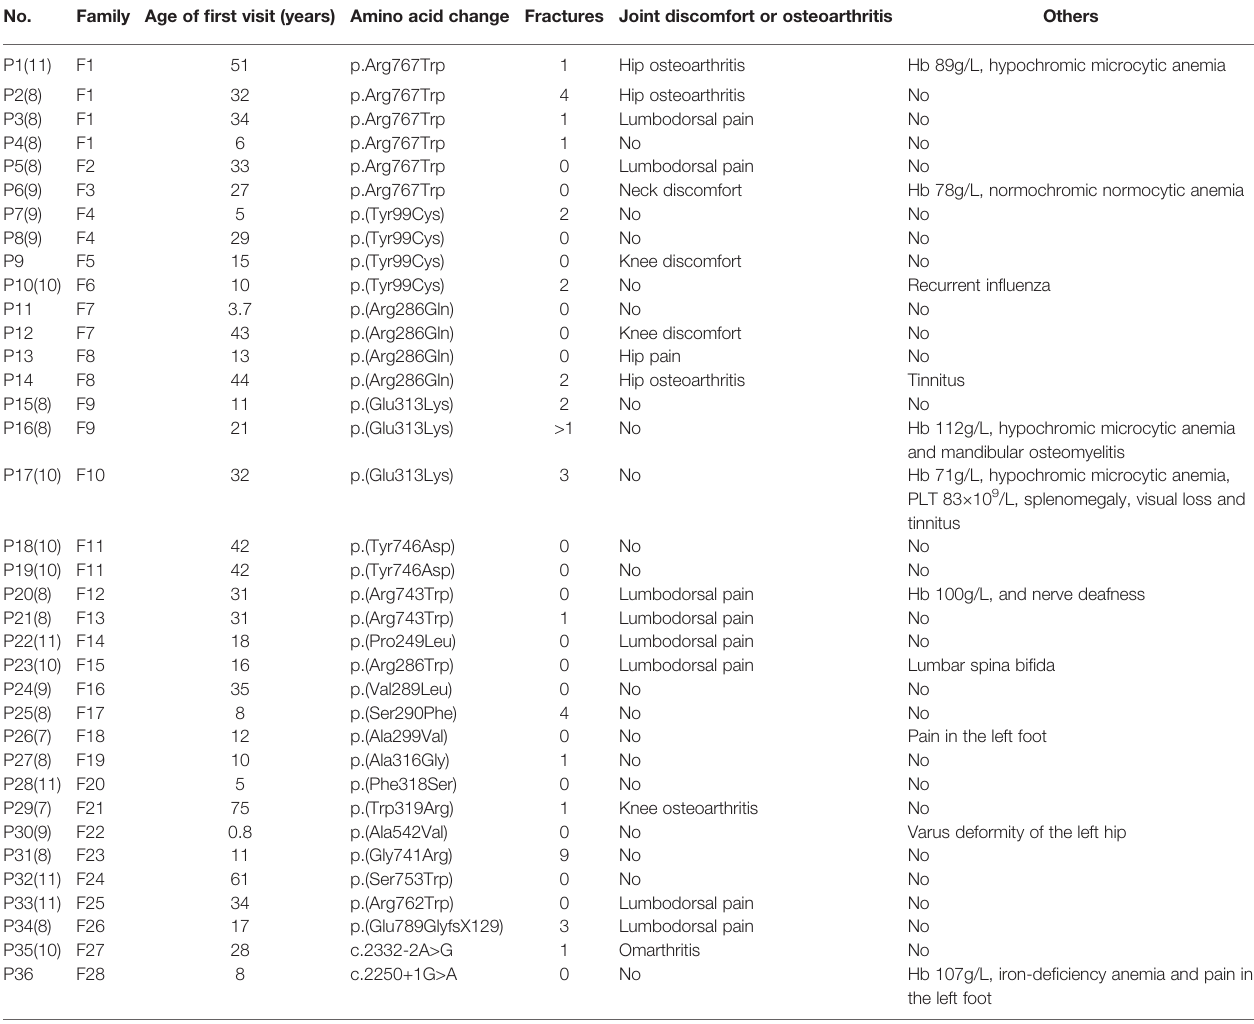
TABLE 4 | Demographic and clinical characteristics of 36 ADO II patients at their fi rst visit. No. Family Age of fi rst visit (years) Amino acid change Fractures Joint discomfort or osteoarthritis Others